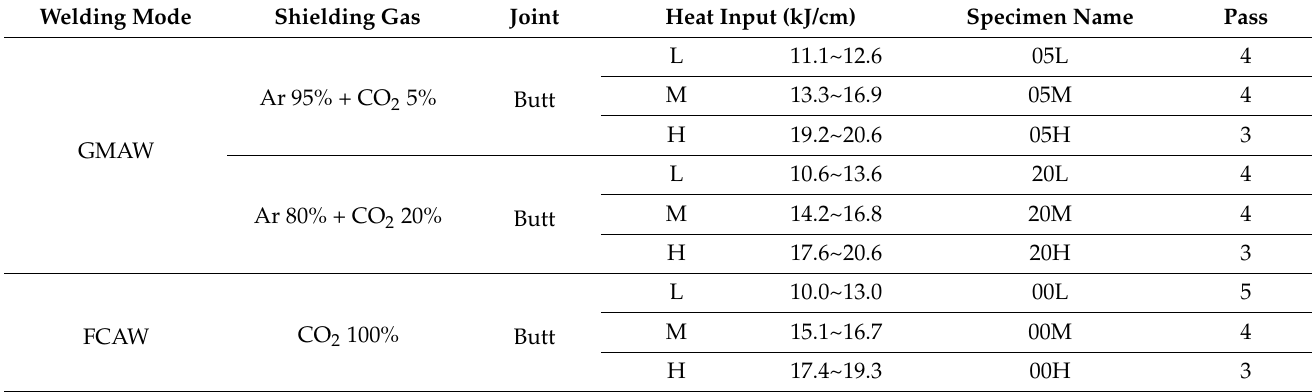
Table 4. Welding conditions for heat input and shielding gas